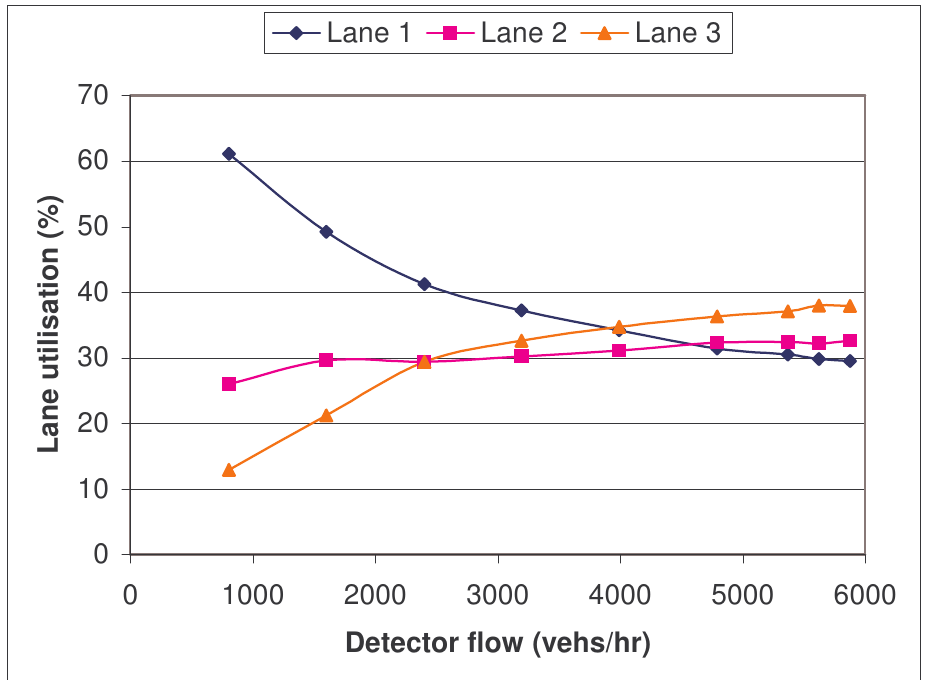
Figure 5. Lane utilisation of the mainline with increasing flow The observed results came from a recent lane changing study which assessed the lane utilisation on the 3-lane mainline of the M27 between Junctions 11 and 12 (Brackstone et al 1998). The Midas loop on the mainline was situated well away from any diverge or